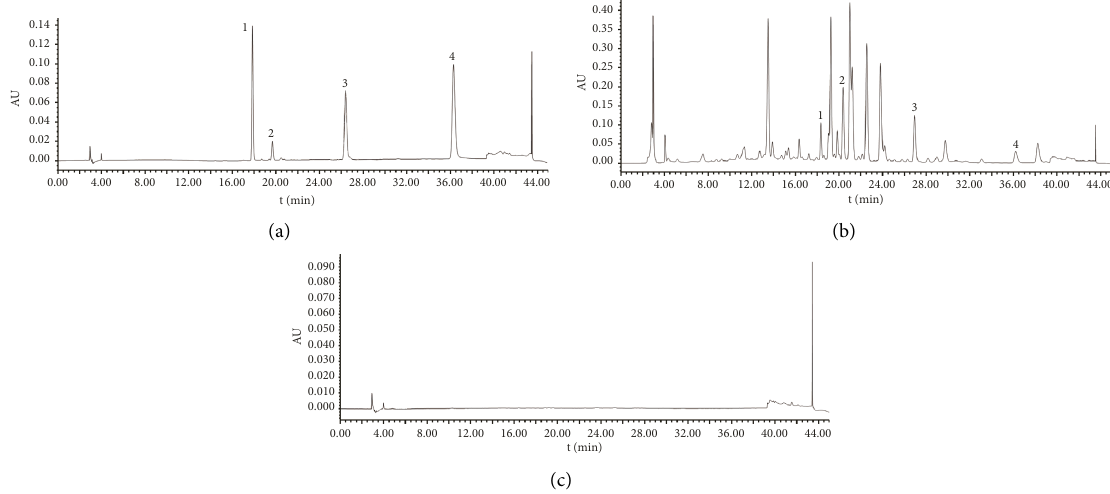
Figure 1: HPLC chromatograms of reference substances (a), samples S8 (b), and methanol blank control (c). (1) rutin; (2) 5-O-cou- maroylquinic acid methyl ester; (3) chlorogenic acid butyl ester; (4) kaempferol. Table 2: Regression equation and linear range of four active ingredients.